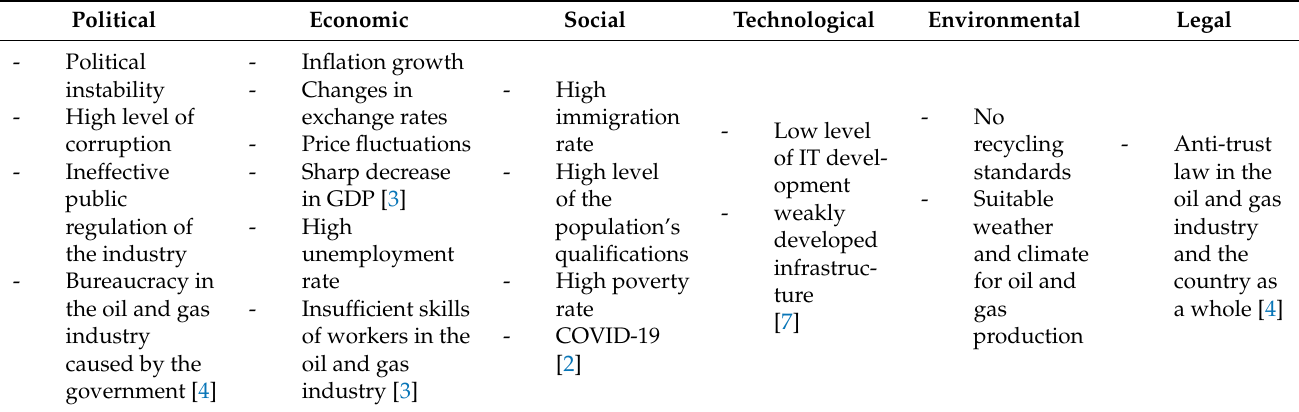
Table 1. The results of a PESTEL analysis of the Lebanese oil and gas